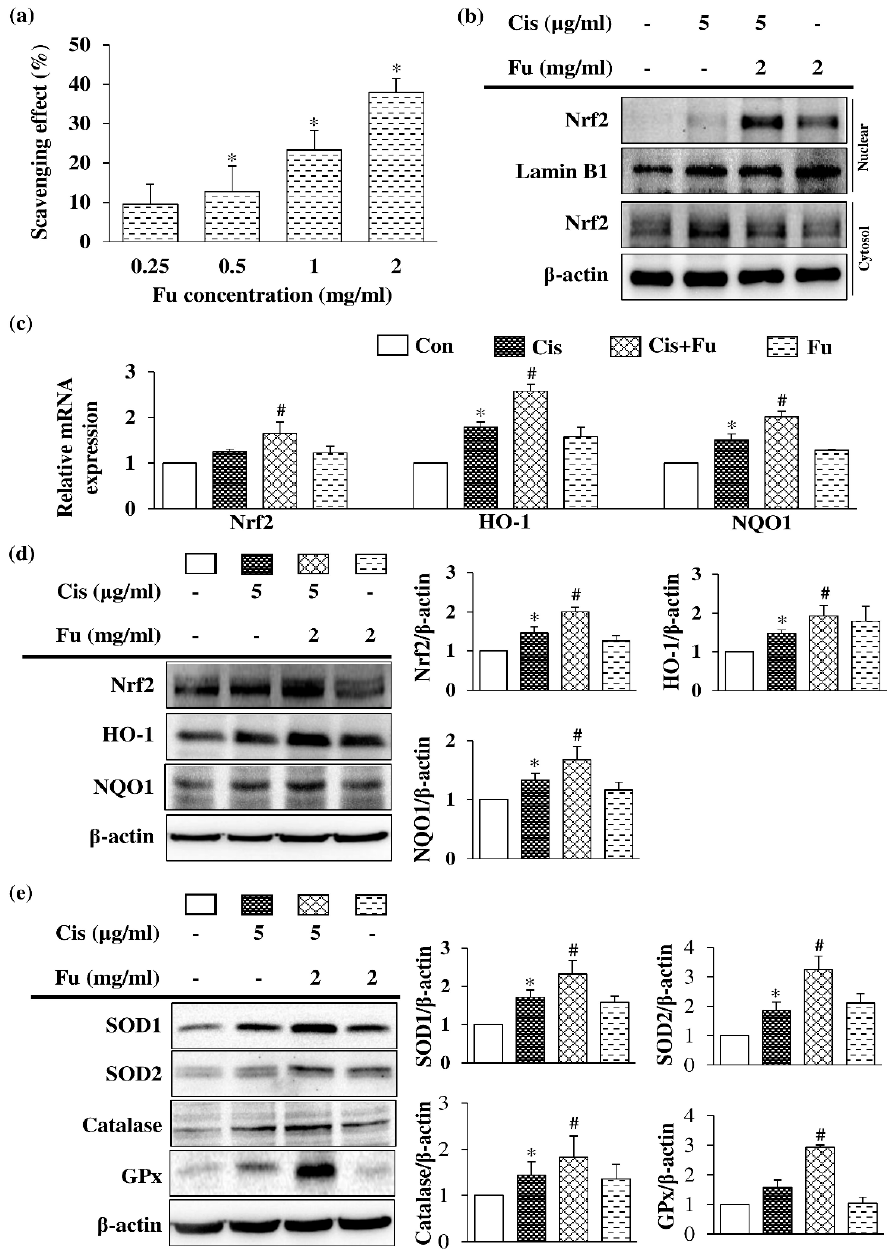
Figure 5. Effects of Fu on the antioxidant response in Cis-treated UB/OC-2 cells. ( a ) The free radical- scavenging activity of Fu (0.25–2 mg/mL) was determined via DPPH assays. Cells were cultured with Fu (2 mg/mL) for 2 h, followed by stimulation with Cis (5 μ g/mL) for 24 h. ( b ) Protein expres- sion levels of Nrf2 in the nuclear and cytosolic fractions were measured via Western blot analysis. Lamin B1 and β -actin were used as internal controls for nuclear and cytosolic fractions, respectively. ( c ) The mRNA expression levels of Nrf2 , Ho1 , and Nqo1 were determined using reverse transcrip- tion-quantitative polymerase chain reaction. ( d ) Determination of Nrf2, HO-1, and NQO1 protein expression levels was based on Western blotting analysis. ( e ) Expression of SOD1, SOD2, catalase, and GPx protein expression levels were determined using Western blot analysis. β -actin was used as a loading control. The results are expressed as the mean ± standard deviation. n = 3 per group. * p < 0.05 vs. the control group; # p <0.05 vs. the Cis group. Fu, fucoidan; Cis, cisplatin; Nrf2, NF-E2–